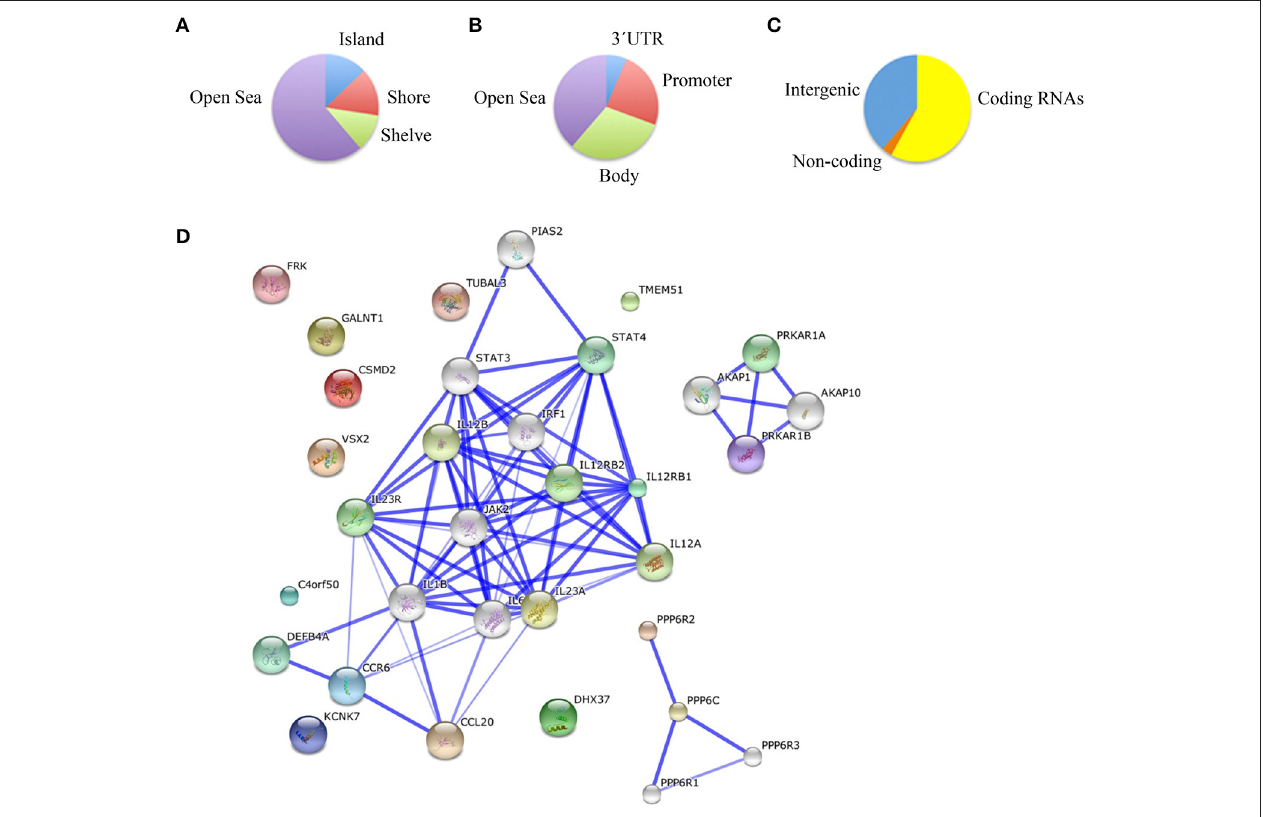
FIGURE 4 | (A) Functional genomic distribution, (B) CpG content and neighborhood context, and (C) associated RNA transcripts of the 55 differentially methylated CpGs between schizophrenic and healthy samples in the ACC; (D) Network analysis in the